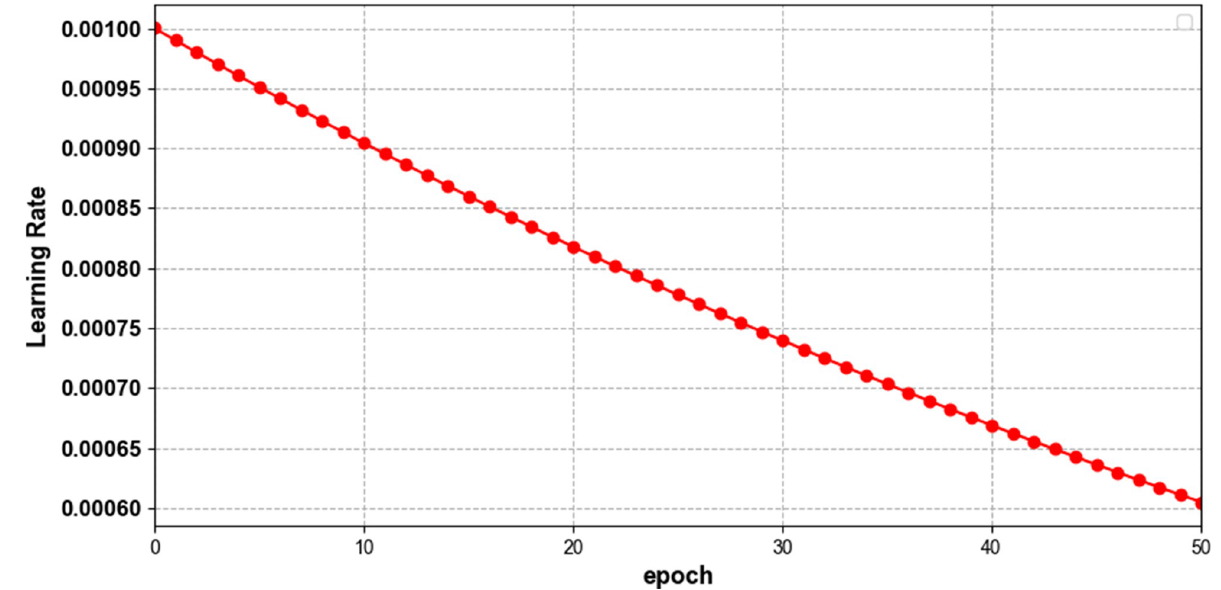
Fig 6. Variation of model learning rate with epoch at CR =